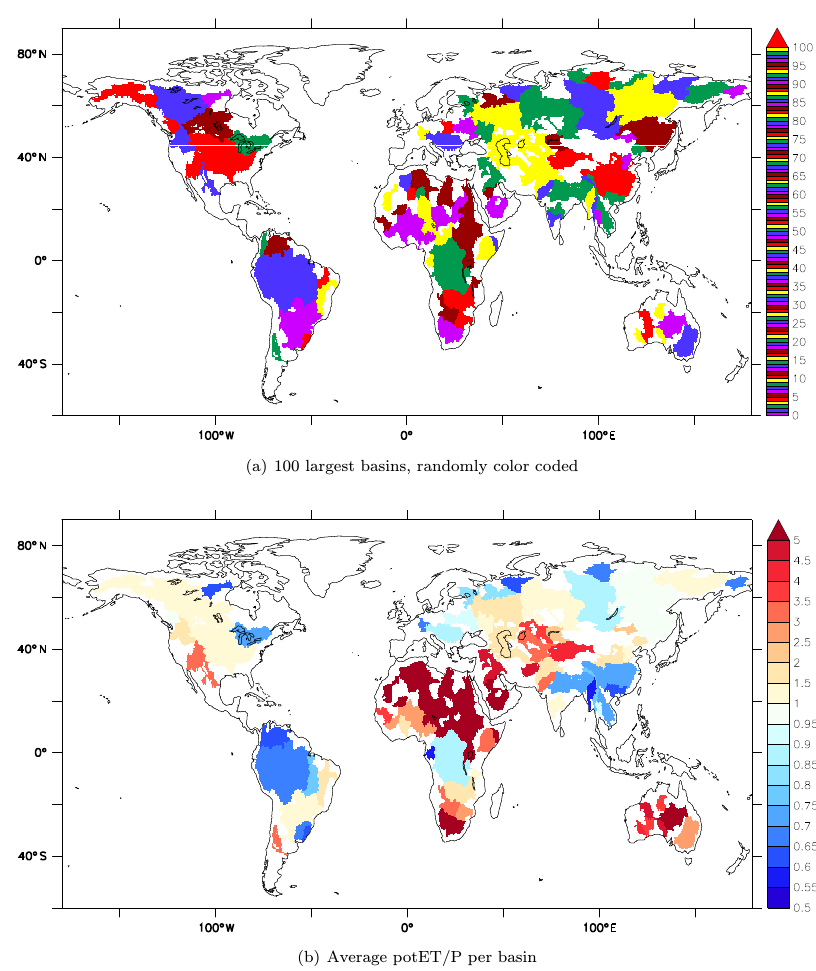
Figure A7. The 100 largest basins on our model grid (a) and the average potET /P per basin (b) . The potET (potential evapotranspiration) is taken from experiment LC2000, and annual averages of potET and P (precipitation) were used. Blue areas are energy limited (potET <P ), and red areas are water limited (potET >P ), with darker colors indicating a stronger energy or water